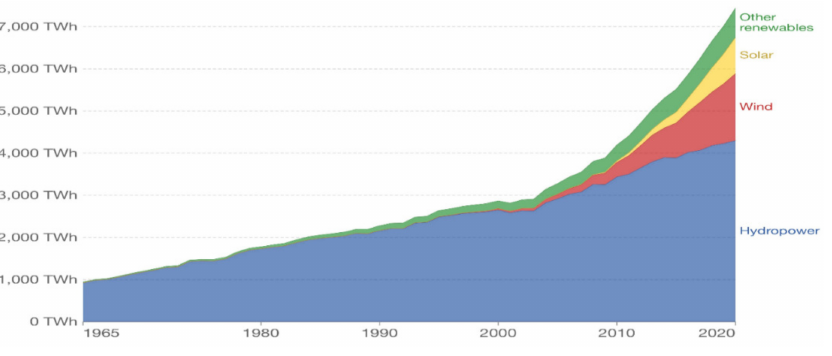
Figure 1. Renewable energy generation in the world. Source: